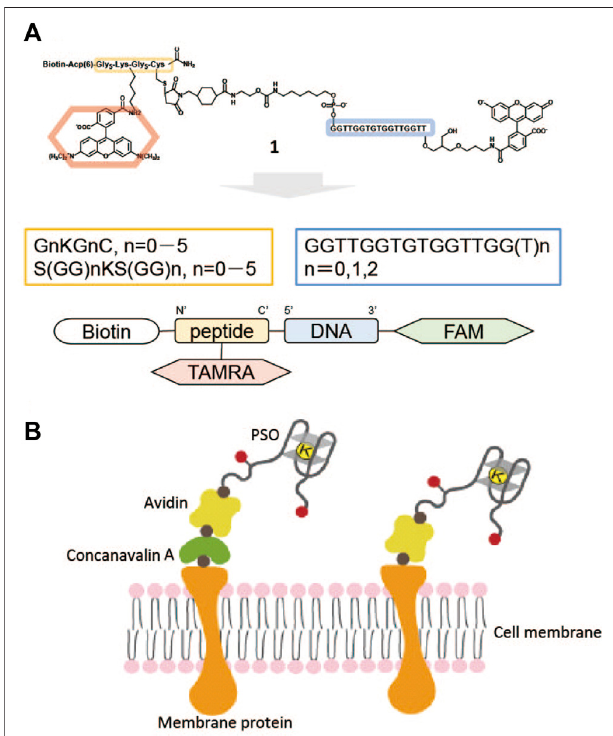
FIGURE 1 | (A) Example of potassium-sensing oligonucleotide (PSO) 1 consisting of oligonucleotide-carrying TBA sequence, peptide linker with biotin,and FRET chromophore pair ofFAM and TAMRA. (B) PSOlocalized on a cell surface through sugar chain, concanavalin A (ConA), and avidin (left) or biotinylated membrane protein, avidin (right). Black circle: biotin; red circle: FRET chromophore pair.